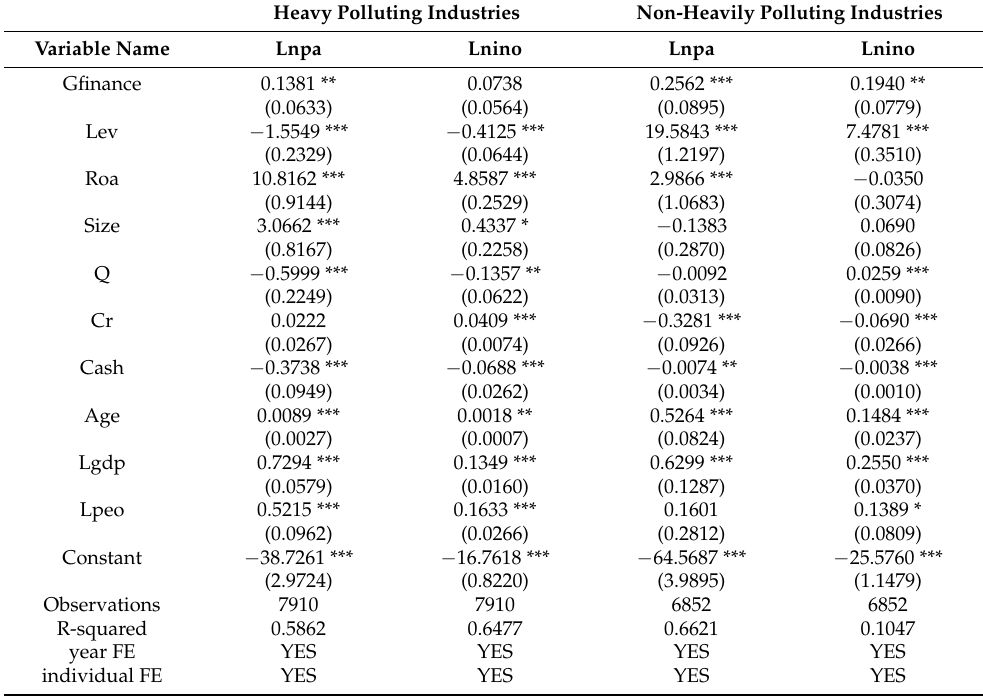
Table 11. Tests for industry heterogeneity of